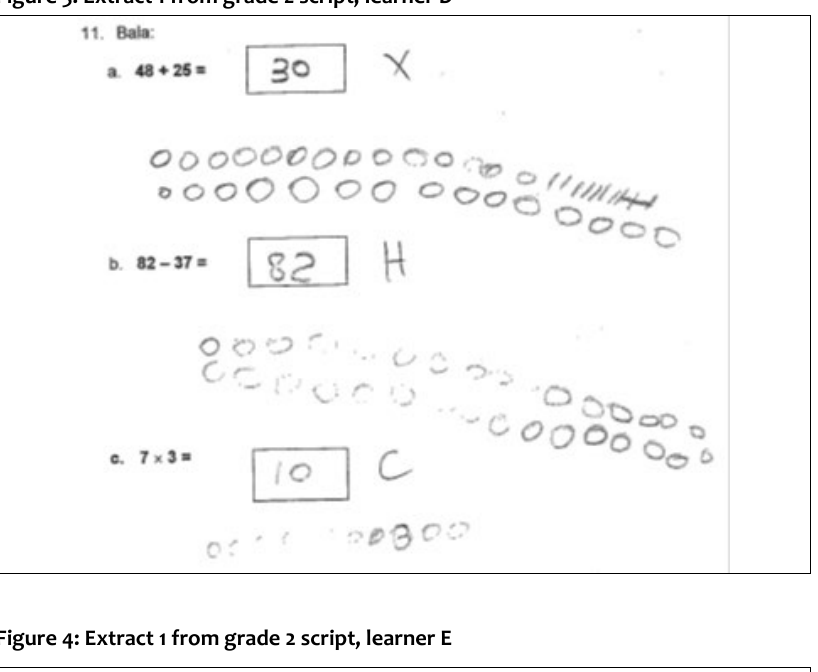
Figure 3: Extract 1 from grade 2 script, learner D